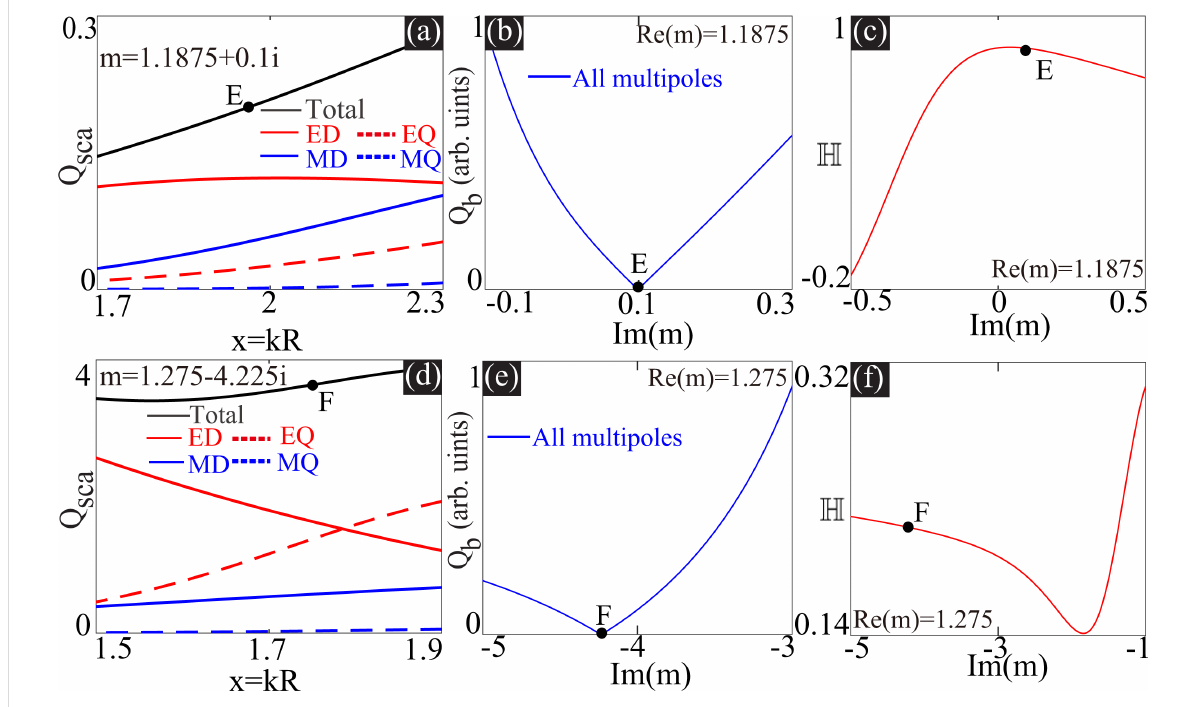
Figure 3: Scattering spectra are shown in (a) for m = 1.1875 + 0.1 i (with loss) and in (d) for m = 1.275 − 4.225 i (with gain). For each scenario, there is an indicated point ( x E ≈ 1.9591 and x F ≈ 1.7492) where the backward scattering is eliminated, as confirmed in (b) and (e). Dependence of Q b (b, e) and (c, f) on Im( m ), at x E with fixed Re( m ) = 1.1875 and at x F with fixed Re( m ) =